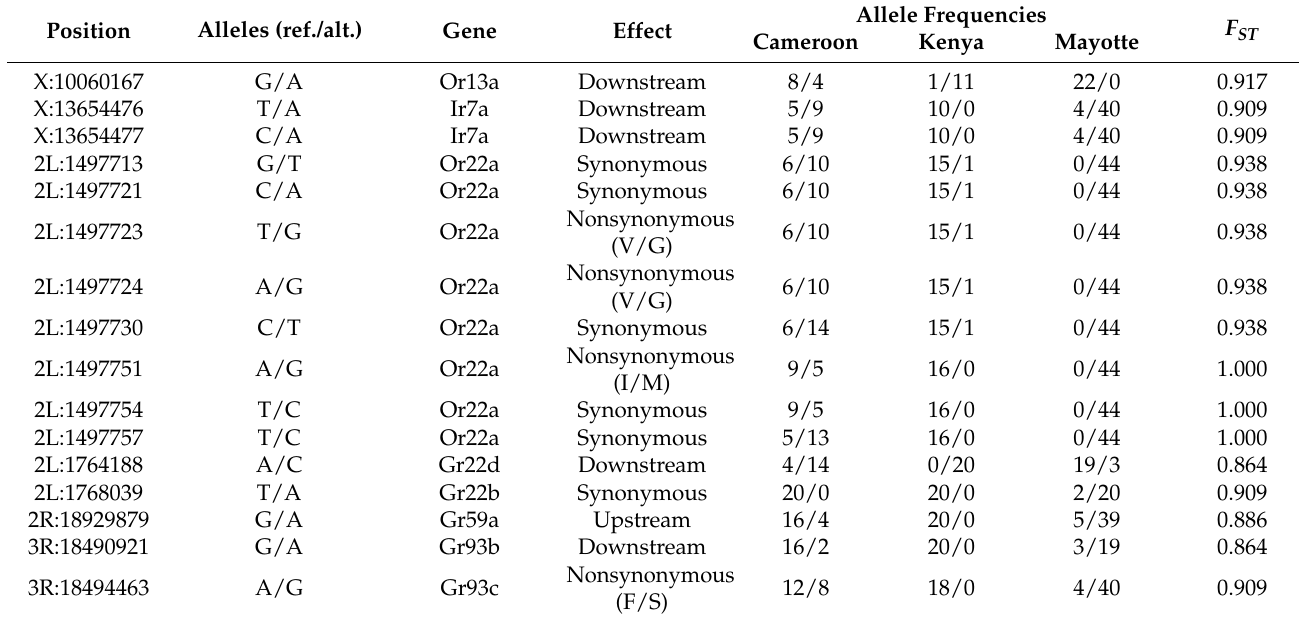
Table 1. List of most differentiating sites in chemosensory genes with F ST values ≥ 0.86 between Kenya and Mayotte populations, corresponding to the 0.90 quantile value estimated from the msms simulation. Position Alleles (ref./alt.)